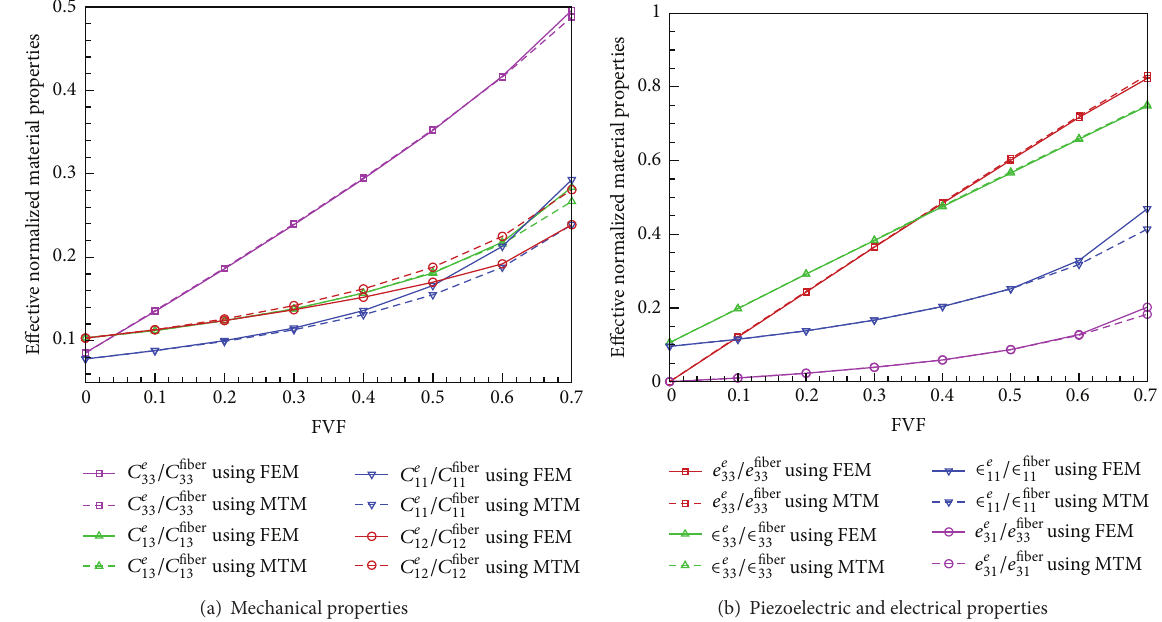
Figure 2: Material mechanical, piezoelectric, and electrical properties of the piezocomposite as a function of the fiber volume fraction.